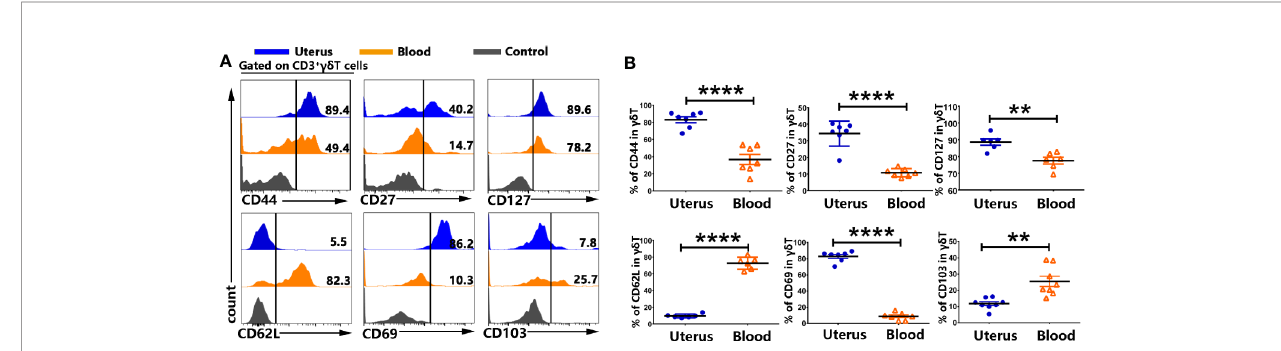
FIGURE 2 | gd T cells from uterus expressed memory and residence markers. The mononuclear cells from uterus and blood were prepared and stained with anti- CD3, gd T, CD44, CD27, CD127, CD62L, CD69, and CD103, and assessed by FACS. Gated on CD3 + gd T cells from uterus (blue) and blood (orange), compared to the control (gray), the representative graphs for the expression of CD44, CD27, CD127, CD62L, CD69, and CD103 were shown (A) . Statistical results (B) from 6-9 independent experiments with six mice in each experiment were shown as mean ± SEM, and the statistical signi fi cance was determined with the Mann – Whitney U test. **<0.01, ****P <